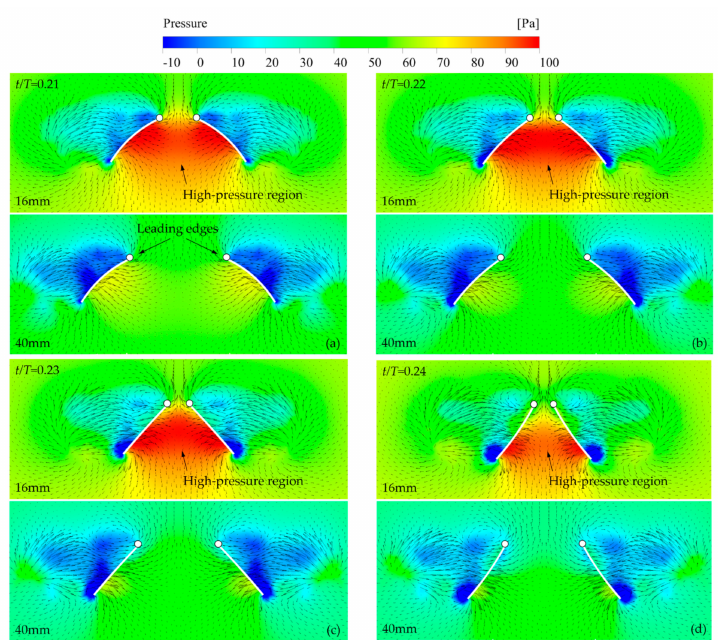
Figure 19. Flow fields in 75%R-plane during down-stroke clap for J = 1. Due to inertia force resulted from the wing mass, the wing camber changes from curve-up ( a , b ) to curve-down ( c , d ). The white curves are the intersections between the wings and the plane, representing wing sections. The leading edges are marked with white